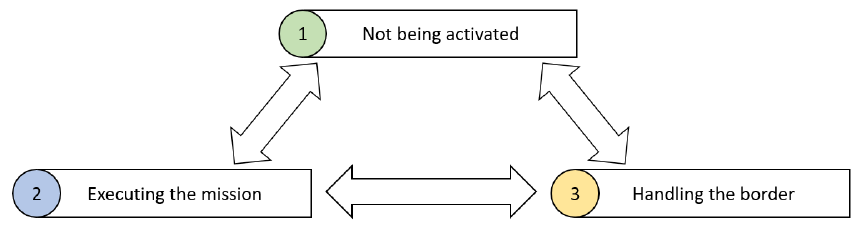
Figure 6. The status of a UAV.